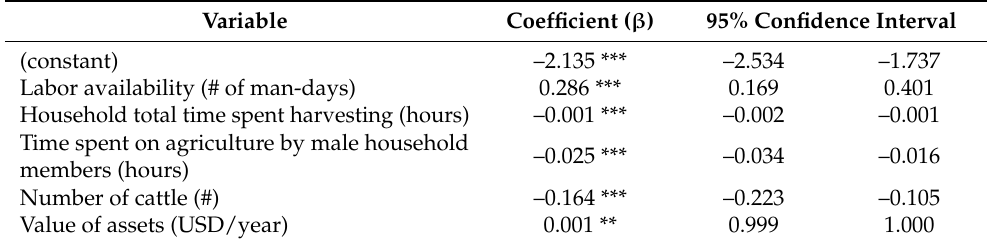
Table 5. Bi-logit model estimation of willingness to purchase fuel by households ( n = 2612).